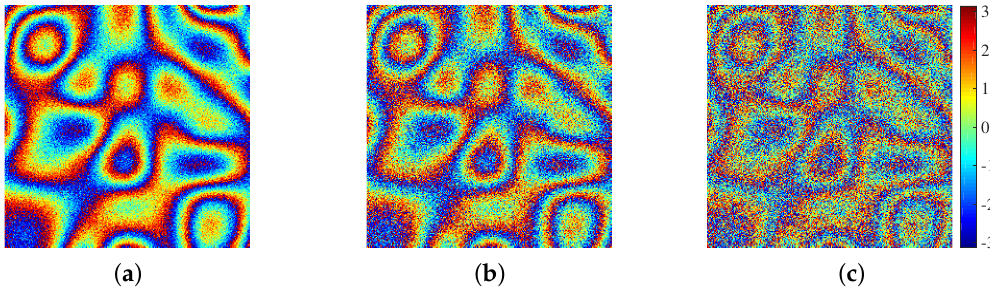
Figure 3. Interferometric phase images with different levels of noise. ( a ) 1.17 dB. ( b ) − 0.87 dB. ( c ) − 2.1